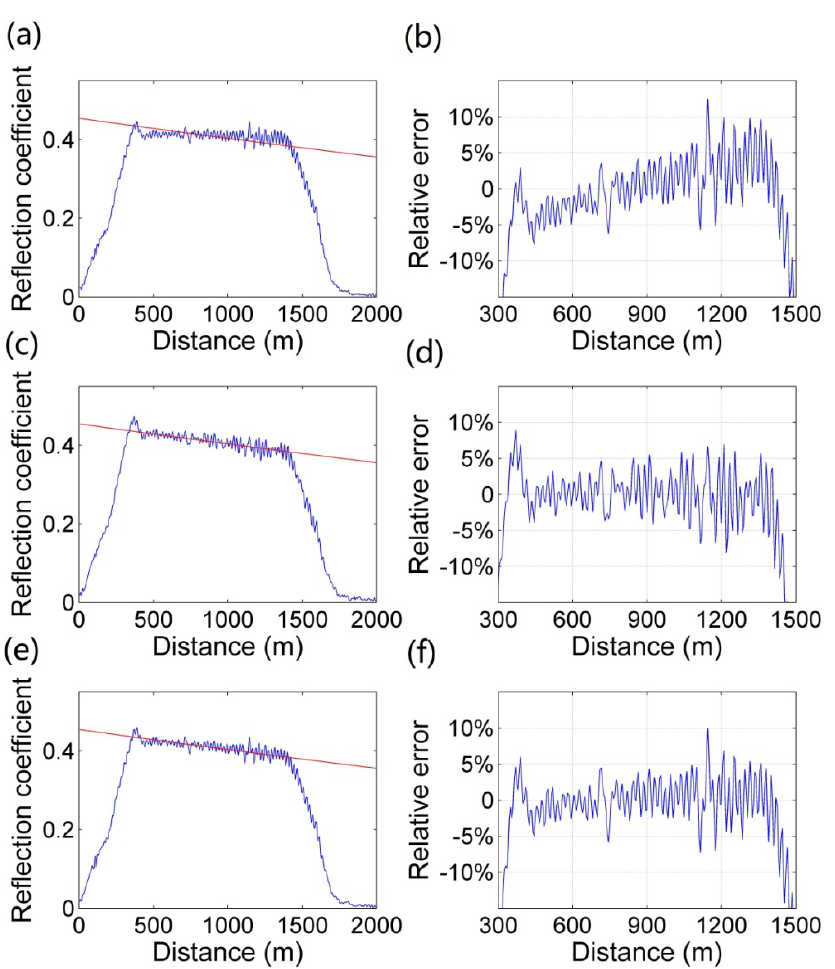
Figure 3. ( a ) Comparison of the calculated reflection coefficient (blue line) of Method 1 and the theoretical reflection coefficient (red line); ( b ) The relative error between the calculated reflection coefficient and the theoretical coefficient of Method 1; ( c ) Comparison of the calculated reflection coefficient (blue line) of Method 2 and the theoretical reflection coefficient (red line); ( d ) The rela- tive error between the calculated reflection coefficient and the theoretical coefficient of Method 2; ( e ) Comparison of the calculated reflection coefficient (blue line) of Method 3 and the theoretical reflection coefficient (red line); ( f ) The relative error between the calculated reflection coefficient and the theoretical coefficient of Method 3.